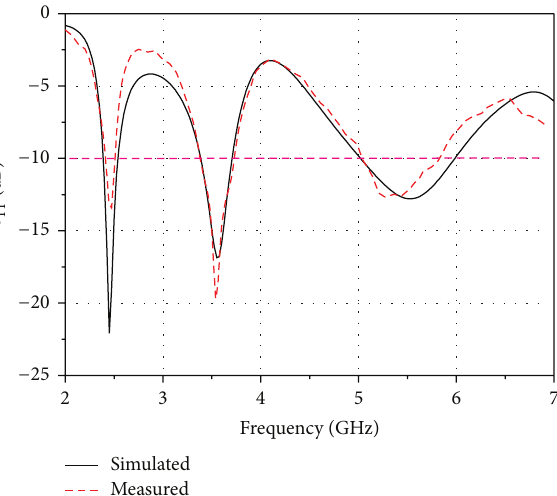
the upper WLAN band moves from 5.55 GHz to 5.15 GHz.